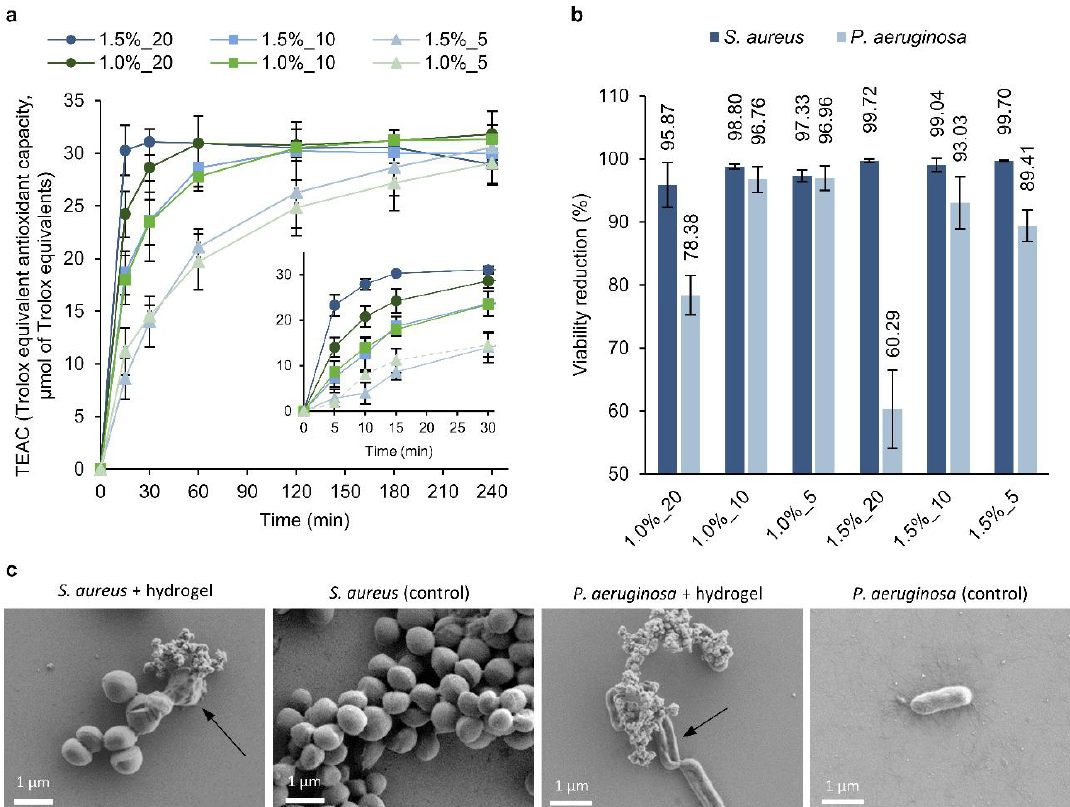
Figure 5. ( a ) The antioxidant activity of the hydrogels was measured using the DPPH assay. Detail of the first 30 min of assay (inset). ( b ) The antibacterial capacity of the hydrogels against S. aureus and P. aeruginosa is expressed as a percent reduction in viability (%). The results are presented as mean values of bacterial viability reduction (%) (n = 3) ± SD. ( c ) SEM images of S. aureus and P. aeruginosa treated with the hydrogels and their respective controls (without